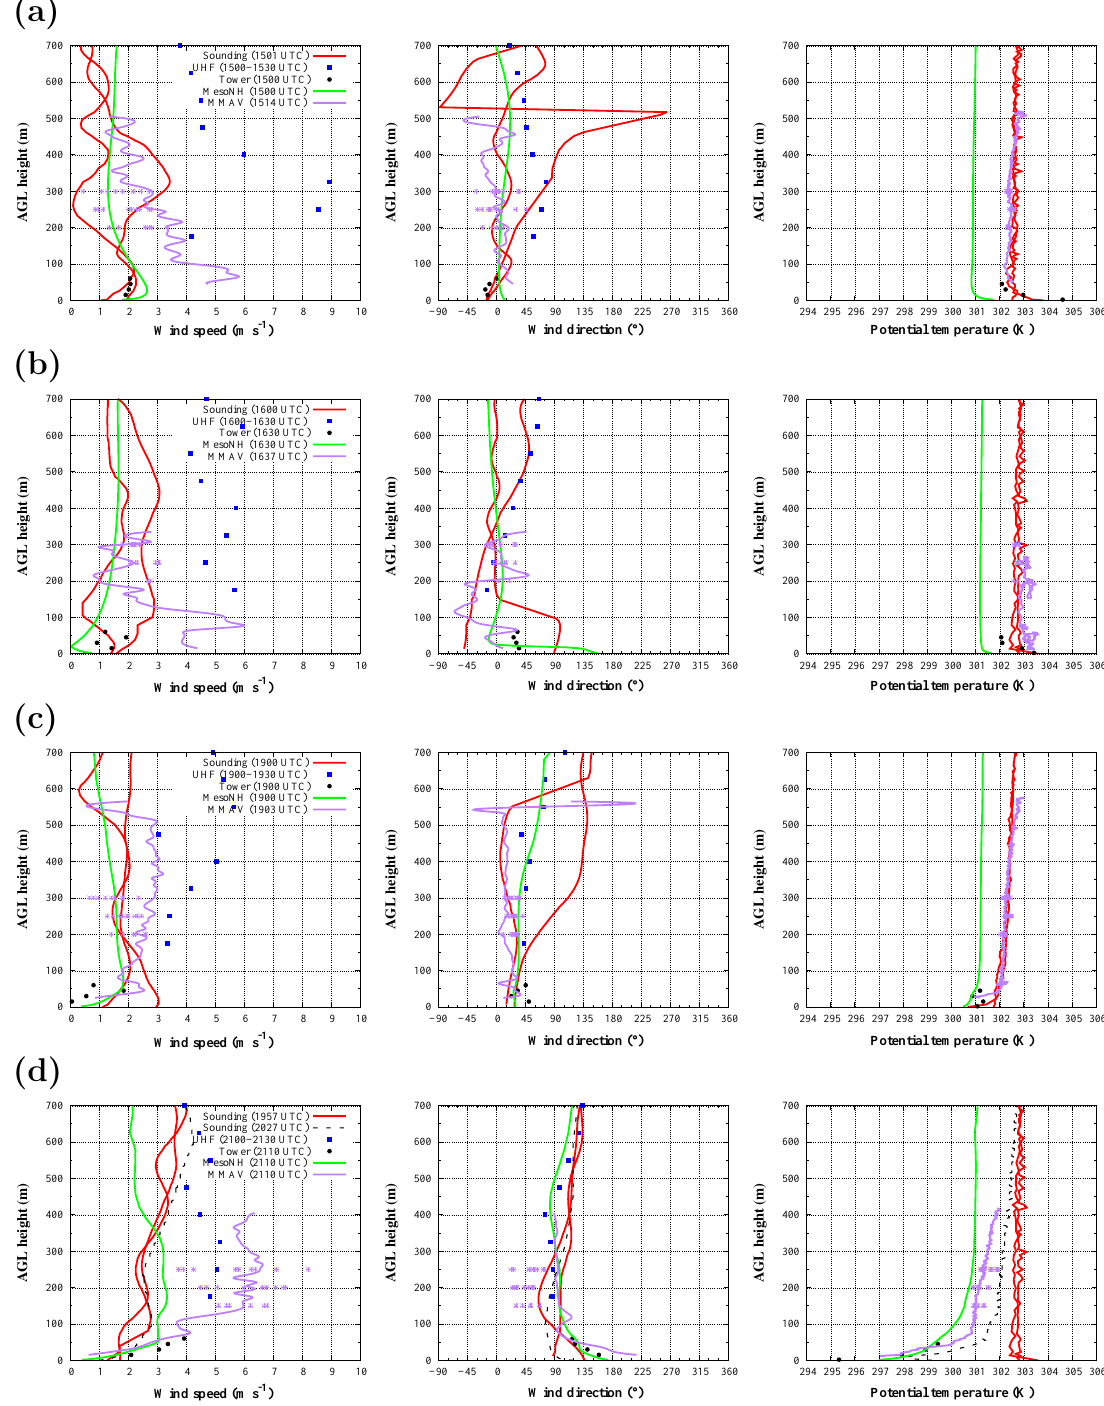
Figure 5. Vertical profiles of the wind speed (in ms − 1 ) on the left, wind direction (in ◦ ) in the centre and potential temperature (in K) on the right, obtained from M 2 AV (in violet) for the four flights of 2 July 2011: (a) 15:00, (b) 16:30, (c) 19:00 and (d) 21:10UTC. Purple dots correspond to mean values for each horizontal leg. M 2 AV data are compared against instantaneous observations from UHF (blue squares), 60m tower (black dots), and frequent (red) and standard soundings (black), together with mesoscale simulation results (green). The legend indicates the corresponding times to each data